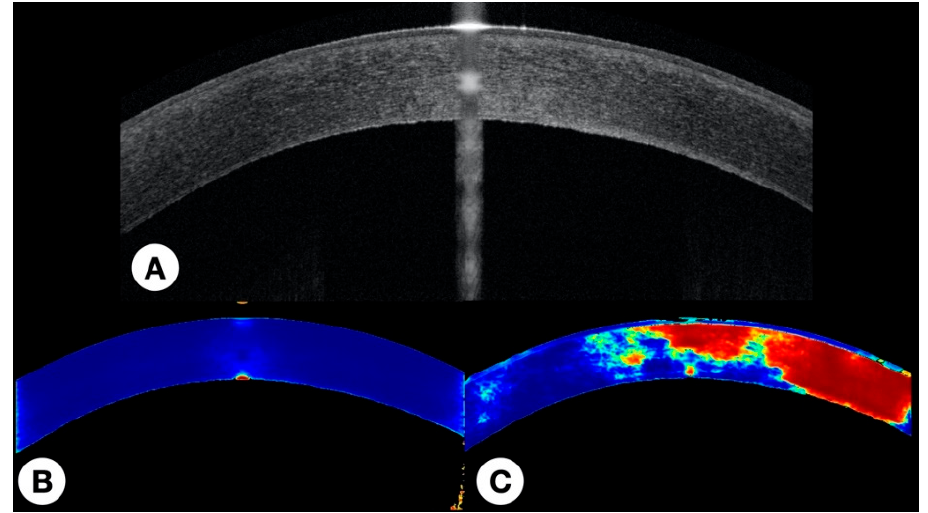
Figure 6. Example of an OCT image ( A ) from a patient with a DCCT of 87 µ m. Corresponding colored heat map of the output probabilities of edema of our previous model ( B ) and of our current pipeline ( C ). Hotter colors indicate higher probabilities of edema. OCT: optical coherence tomography; DCCT: differential central corneal thickness.